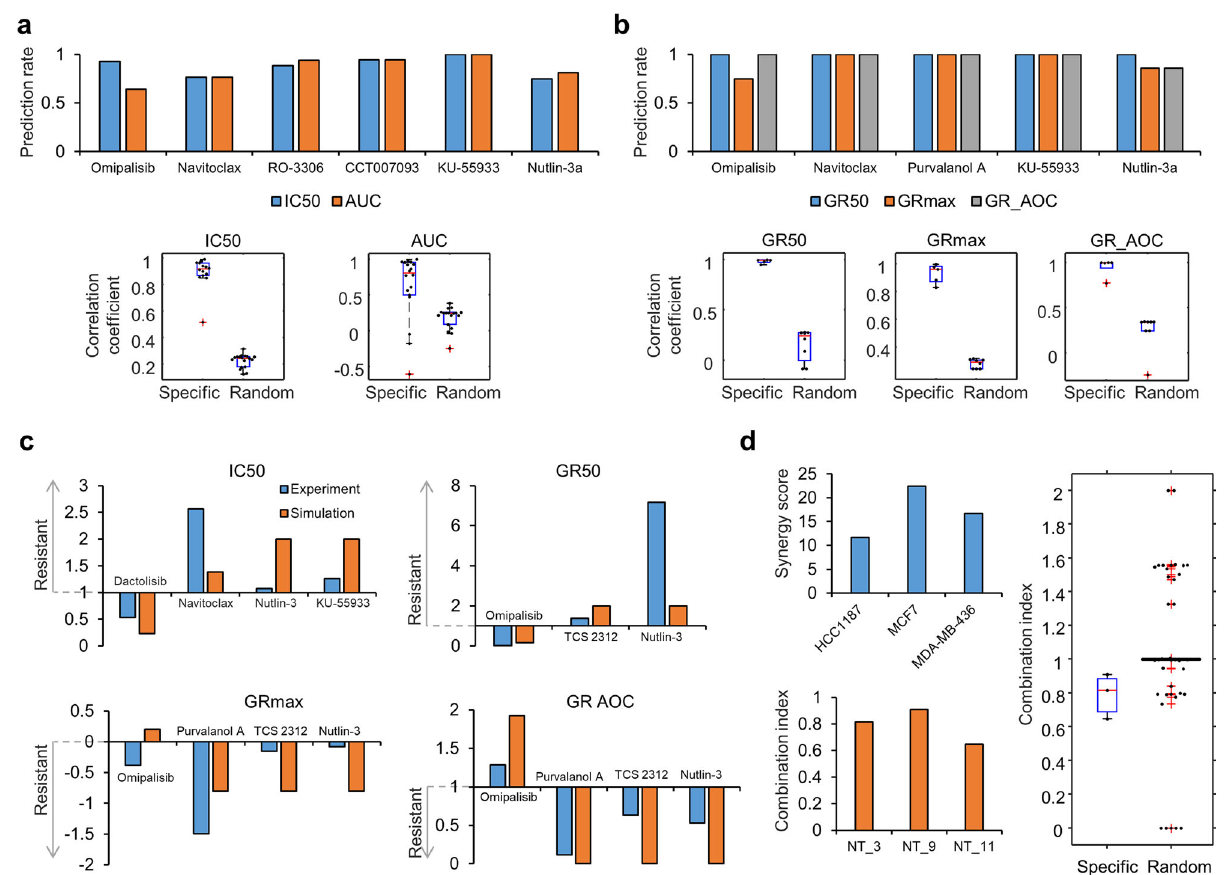
Fig. 2 Comparison of perturbation simulation with database for drug response. a , b Comparison of predicted drug response with ( a ) IC50 and AUC from GDSC data and b GR50, GRmax, and GR_AOC from GRbrowser data. Each value from database and simulation of corresponding cancer cell-speci fi c networks was categorized as sensitive or resistant according to a threshold. Prediction rates were calculated for selected drugs (upper panel). Correlation coef fi cients were calculated between values from database and simulation of corresponding cancer cell-speci fi c networks or 100 networks with random alterations (bottom). c Comparison of predicted drug response between simulation results of the control network and experimental data of MCF10A cells. Each sensitivity metric was normalized to its threshold for comparison. d Comparison of predicted synergistic effects with DREAM challenge data for combination of AKT_1 and BCL2_2 compounds in HCC1187, MCF7, and MDA-MD-436 cell lines. (left). Synergy score over 0 is categorized as sensitive in DREAM challenge data. Combination index was calculated from simulation of corresponding cell line-speci fi c networks, and combination index under 1 is categorized as sensitive. Combination index from simulation of 100 networks with random alterations was mostly 0, indicating no synergistic effect (right). We used experimental values of the AKT inhibitor omipalisib or dactolisib, the BLC2 inhibitor navitoclax, the CYCE inhibitor RO-3306 or purvalanol A,